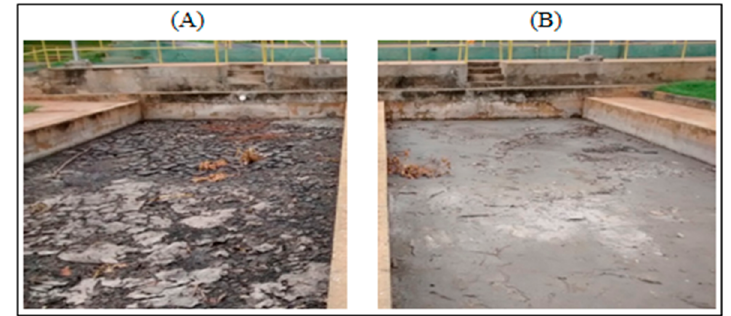
Figure 1. ( A ) Drying bed with dry primary sewage sludge. ( B ) Drying bed with primary sewage sludge after discharge.